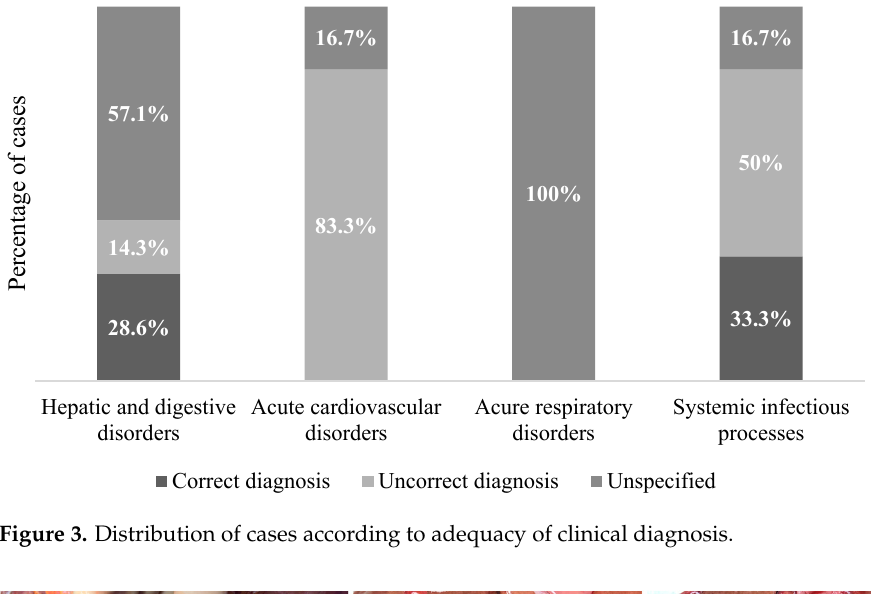
Figure 3. Distribution of cases according to adequacy of clinical diagnosis.